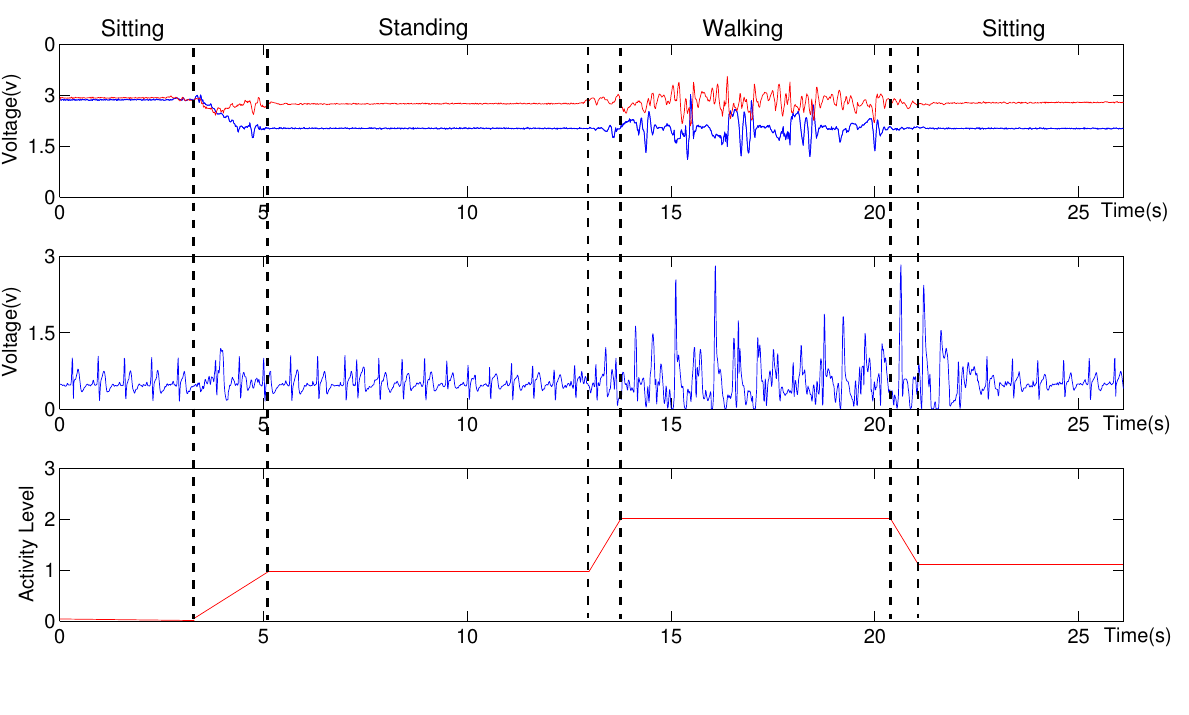
Algorithm 1 Human Activity Classification